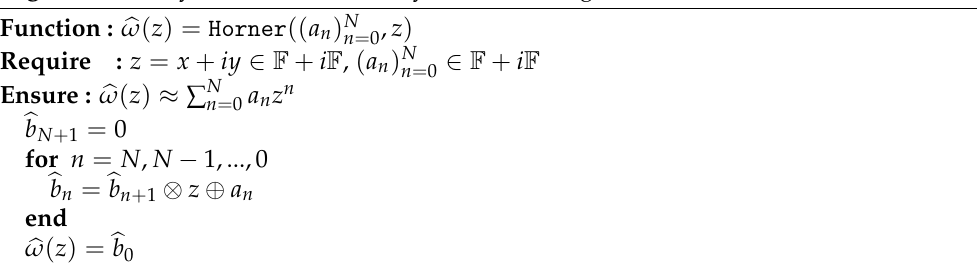
Algorithm 6 Polynomial evaluation by the Horner